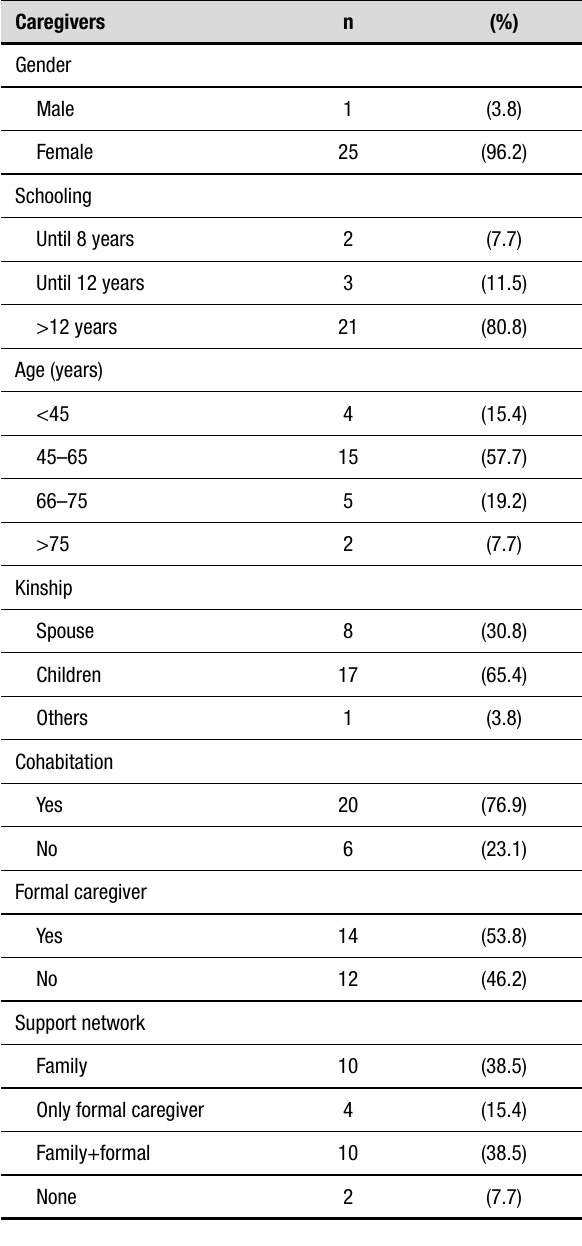
Table 2. Characteristics of family caregivers.